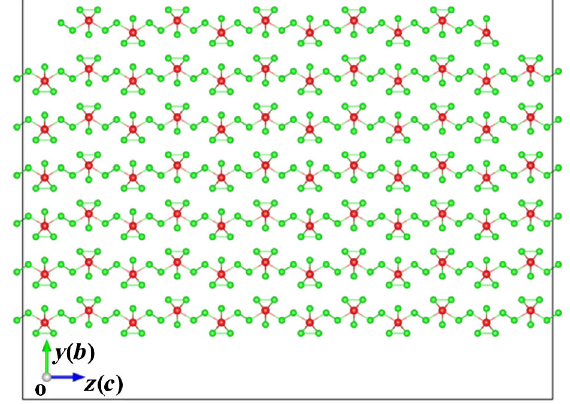
FIG. 5. A ZrTe 5 ribbon terminated with a Te-Te zigzag chain (top left) and a ZrTe 3 chain (top right) is put on a six-layer-thick bulk ZrTe 5 . The width of the ribbon shown here is five c-lattice constants. The interlayer distance is 7.5 Å, which leads 3D ZrTe 5 to be in a weak TI [24].